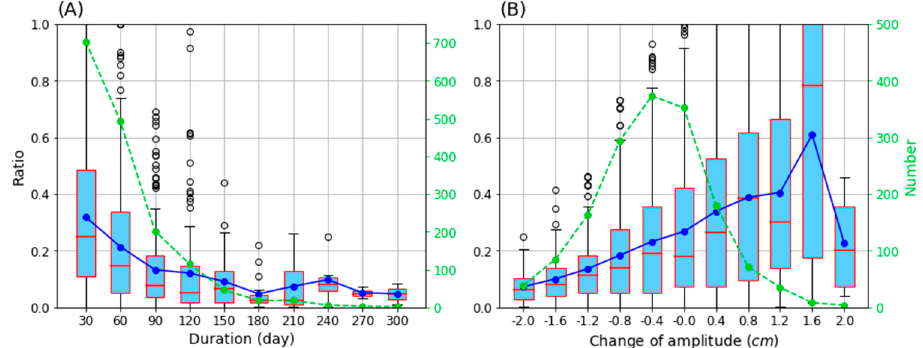
Figure 9. As in Figure 8, but for ( A ) eddy duration and ( B ) change of amplitude.